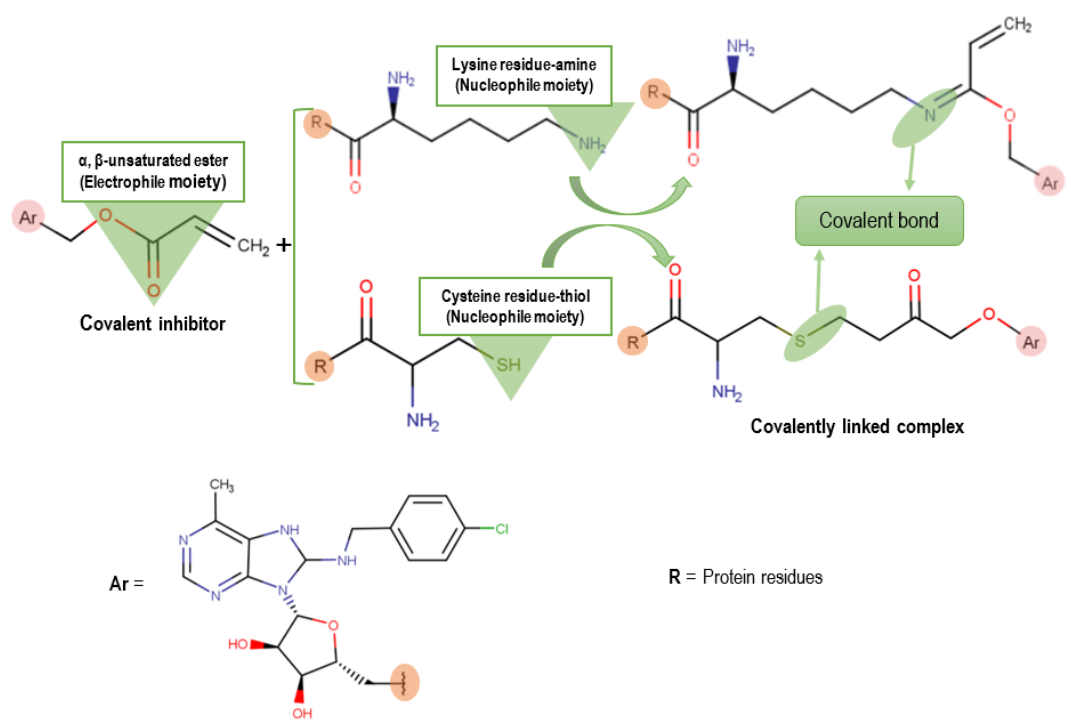
Figure 2. A schematic summarizing the covalent reaction mechanism between a covalent inhibitor and the protein residues lysine and cysteine.